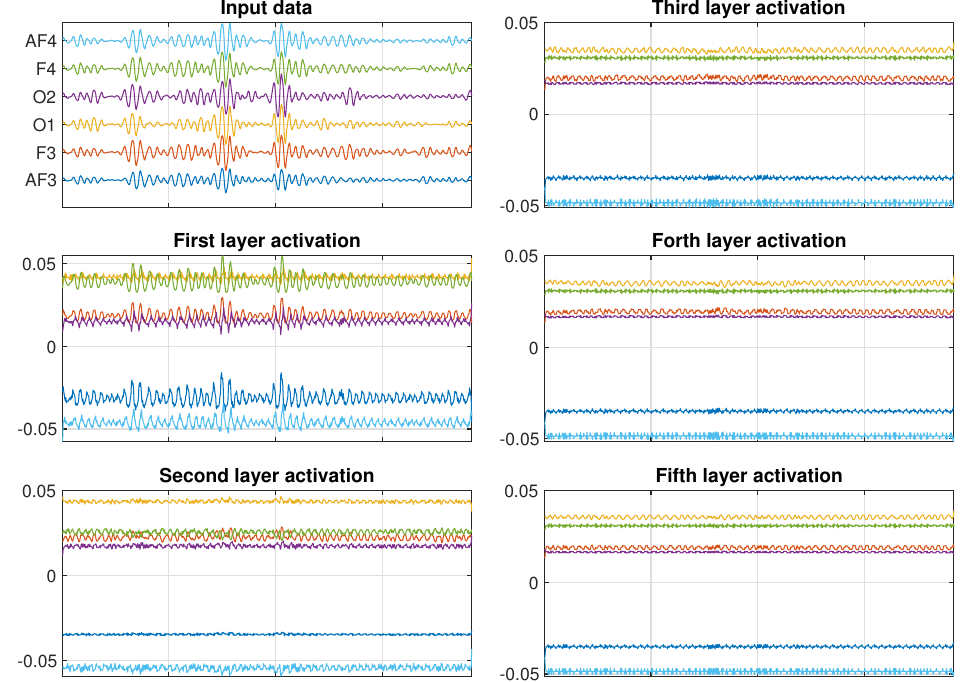
Figure 13. Projection of biggest activation of each CNN layer in the input domain for Subject 11 and KSS =